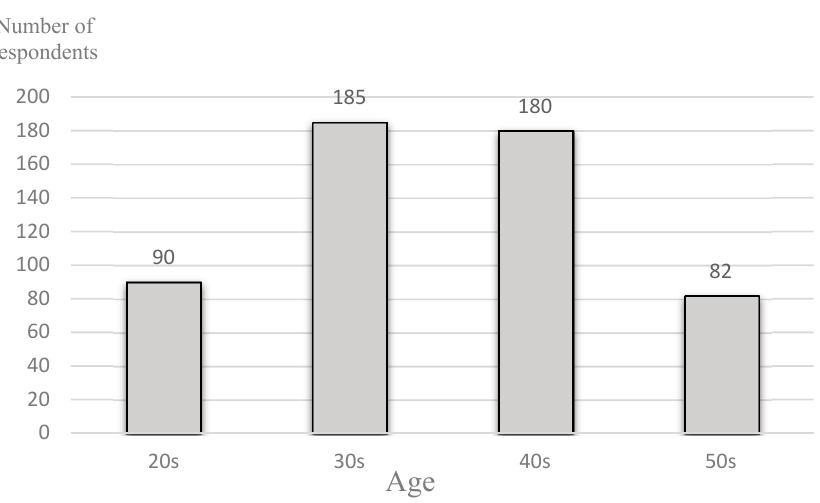
Figure 1. Age distribution of subjects ( N = 537).